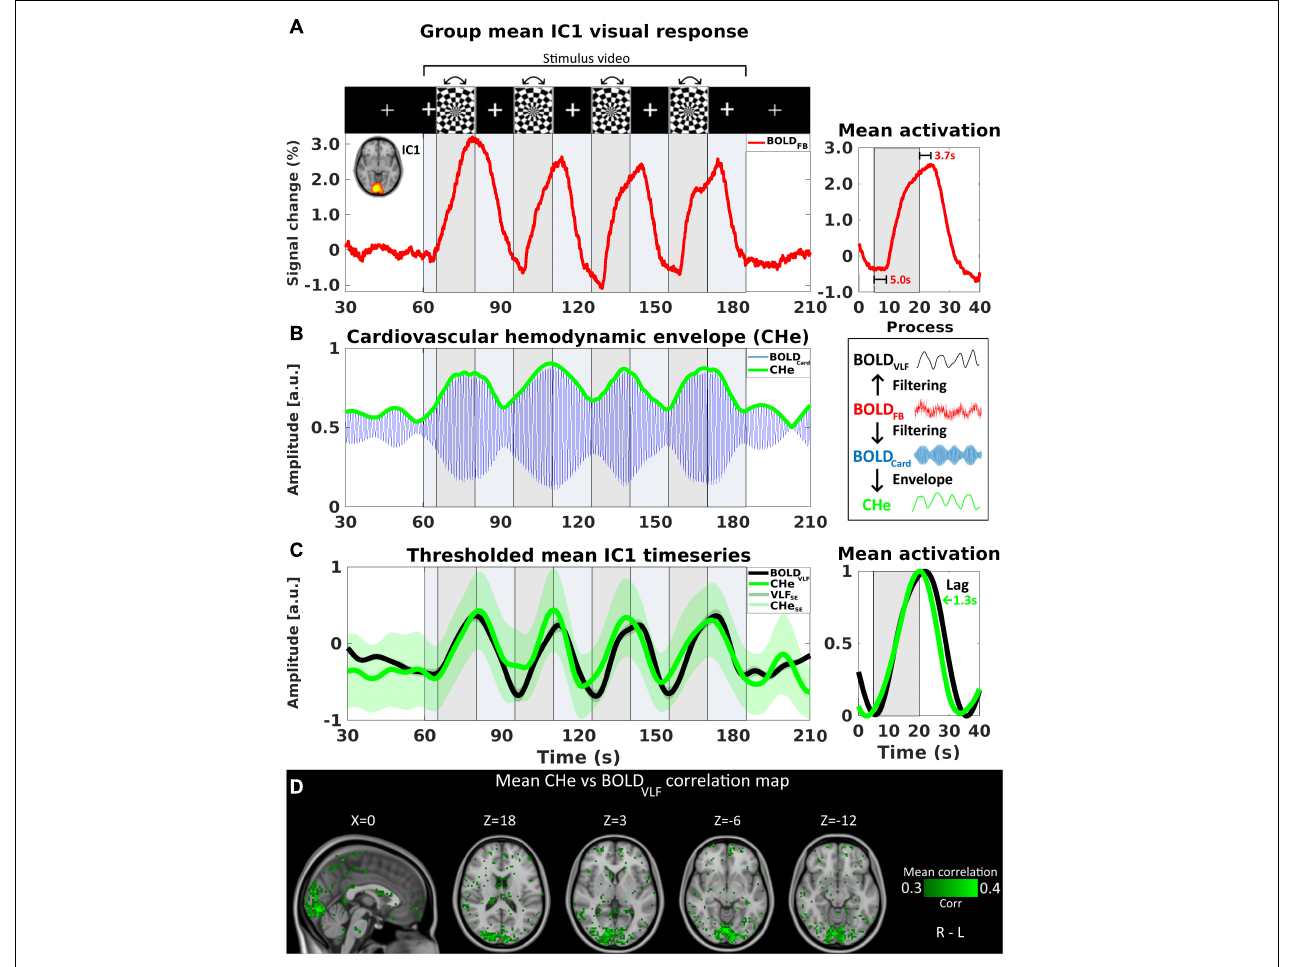
FIGURE 1 | The cardiovascular hemodynamic envelope (CHe) reflects an increase in cardiovascular pulsation amplitude in V1 visual cortex during rotating checkerboard activation. Activation timing is marked with gray background, and stimulus video duration with light blue color. For (A–D) , n = 23. (A) IC1, representing primary visual cortex (V1), group-level mean signal increase of the original full-band signal (BOLD FB ). (B) Bandpass filtered cardiac frequency signal, BOLD Card in blue color signal reveals an oscillating cardiovascular pulsation and the envelope signal CHe in green color. (C) Normalized group mean time-series of BOLD VLF response ( ± SE, black) shown with CHe ( ± SE, green) representing cardiovascular amplitude with a cross-correlation threshold of at least 0.3. The mean CHe time signal matches with the BOLD VLF time domain signal and on average the CHe preceded the BOLD VLF by 1.3 s. (D) An intra-voxel correlation map between CHe and BOLD VLF voxel signals, with corresponding correlation coefficients color-coded in